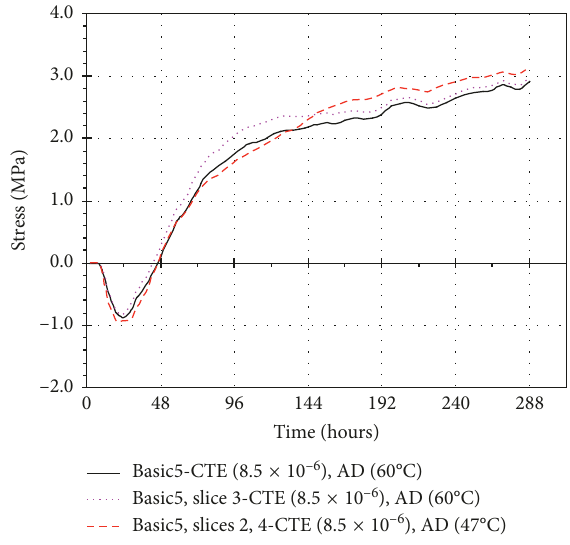
Figure 22: Stress developments in the concrete